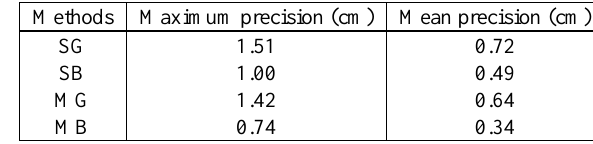
Table 1. The ranging accuracy and precision of measured